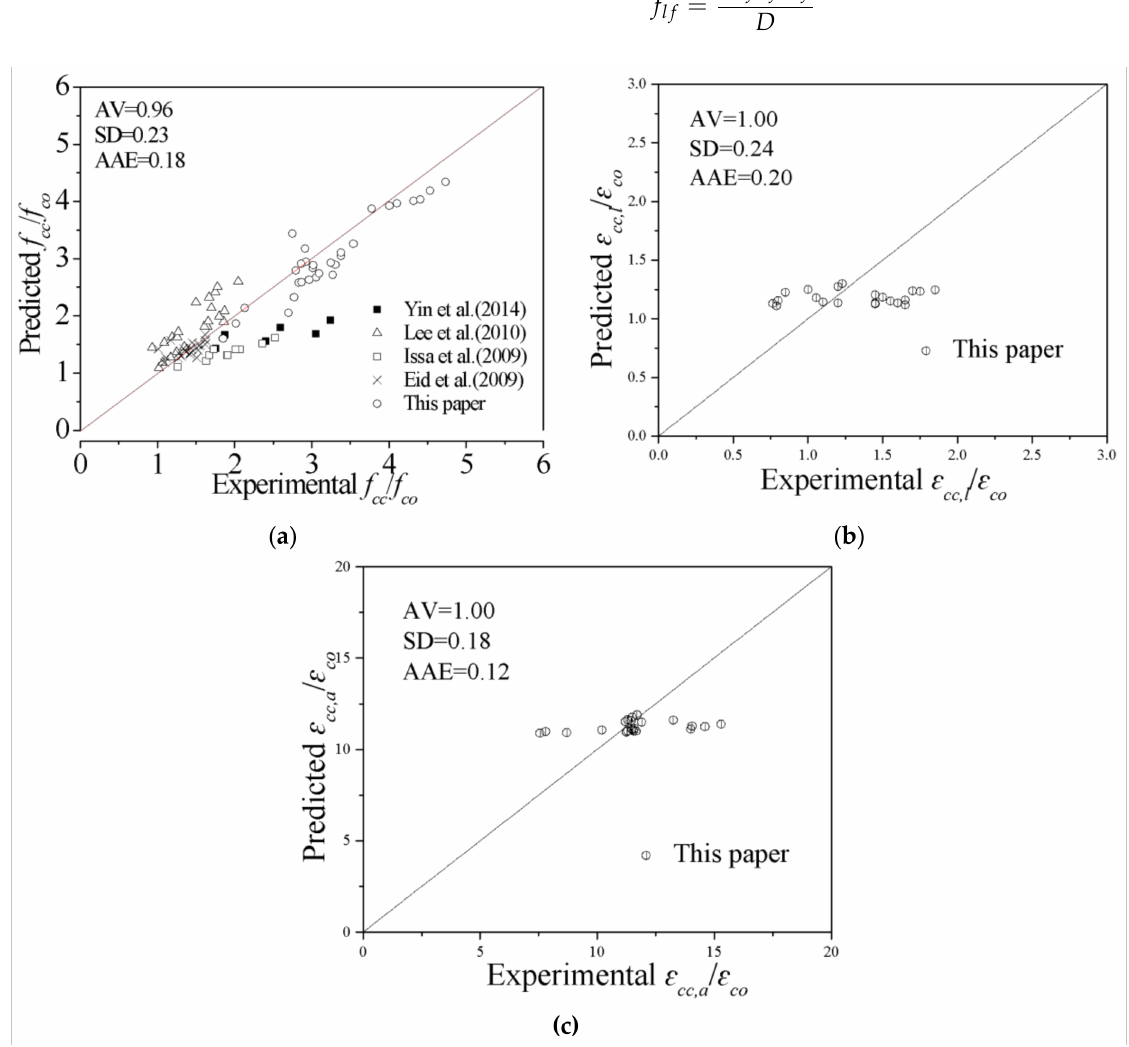
Figure 13. Evaluation of the peak point models. ( a ) Peak stress ( b ) Local peak strain ( c ) Overall peak